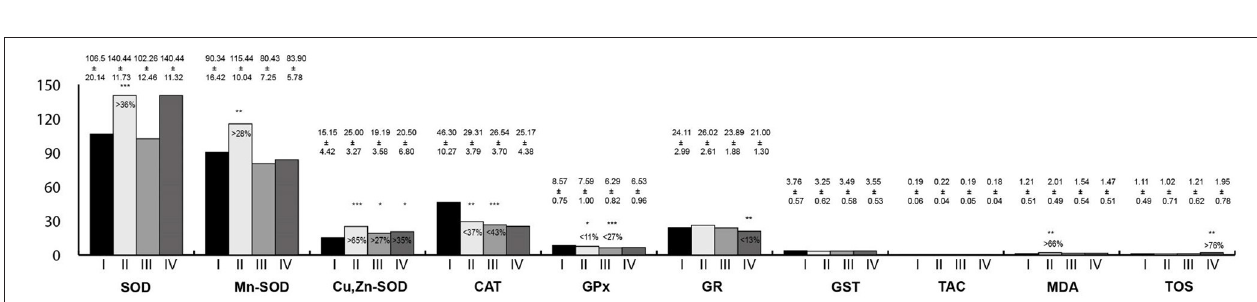
FIGURE 3 | Oxidative stress parameters in the esophagus homogenates. I, control group; II, group exposed to LF-EMFs; III, group exposed to RF-RMF; IV, group exposed simultaneously to LF-EMFs and RF-EMFs; SOD, superoxide dismutase (NU/mg protein); Mn-SOD, manganese-dependent superoxide dismutase (NU/mg protein); Cu,Zn-SOD, copper- and zinc-dependent superoxide dismutase (NU/mg protein); CAT, catalase (IU/g protein); GPx, glutathione peroxidase (IU/g protein); GR, glutathione reductase (IU/g protein); GST, glutathione S-transferase (IU/g protein); TAC, total antioxidant capacity (mmol/g protein); MDA, malondialdehyde ( µ mol/g protein); TOS, total oxidative status. Differences statistically important at * p < 0.05; ** p < 0.01; *** p < 0.001; p -value: particular study group vs. control group; p -value was added only if statistically significant. Percent values mean difference between study and control group; they were given if p -values were significant.